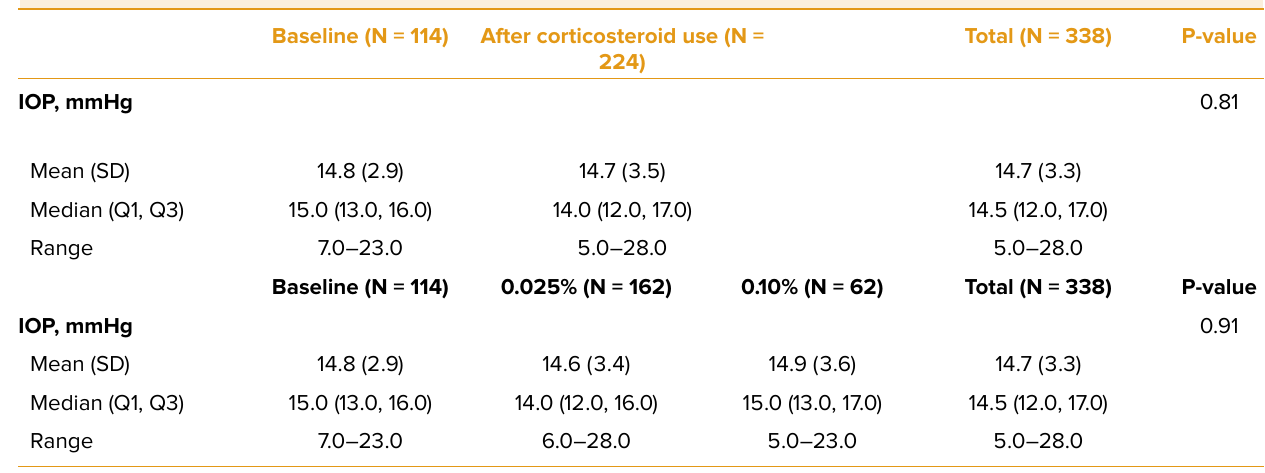
Table 3. Description of IOP by corticosteroid use and by corticosteroid strength.